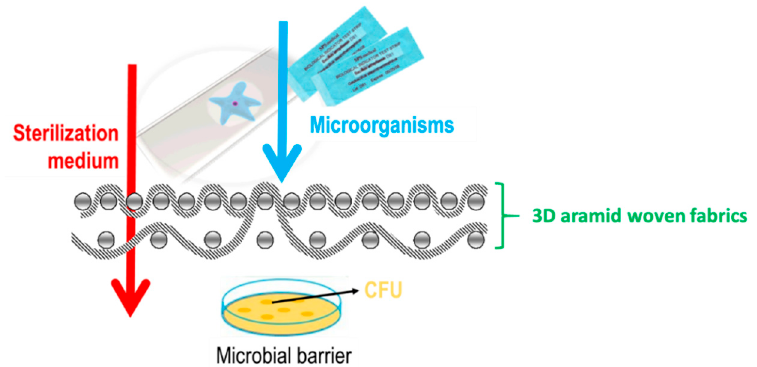
Figure 5. Microbial barrier.